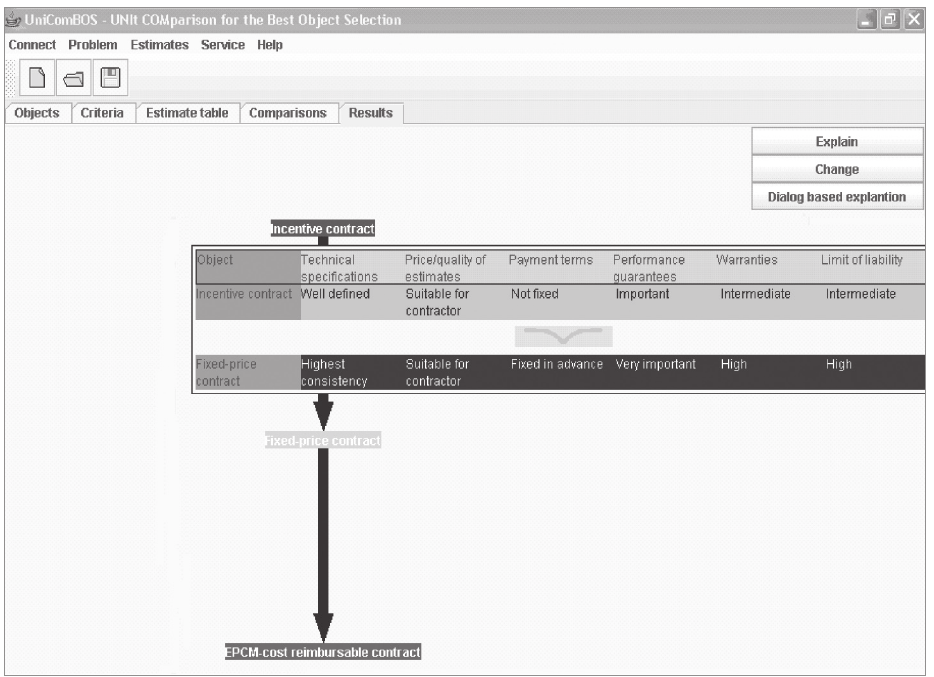
Fig. 2. Results of comparative assessment of